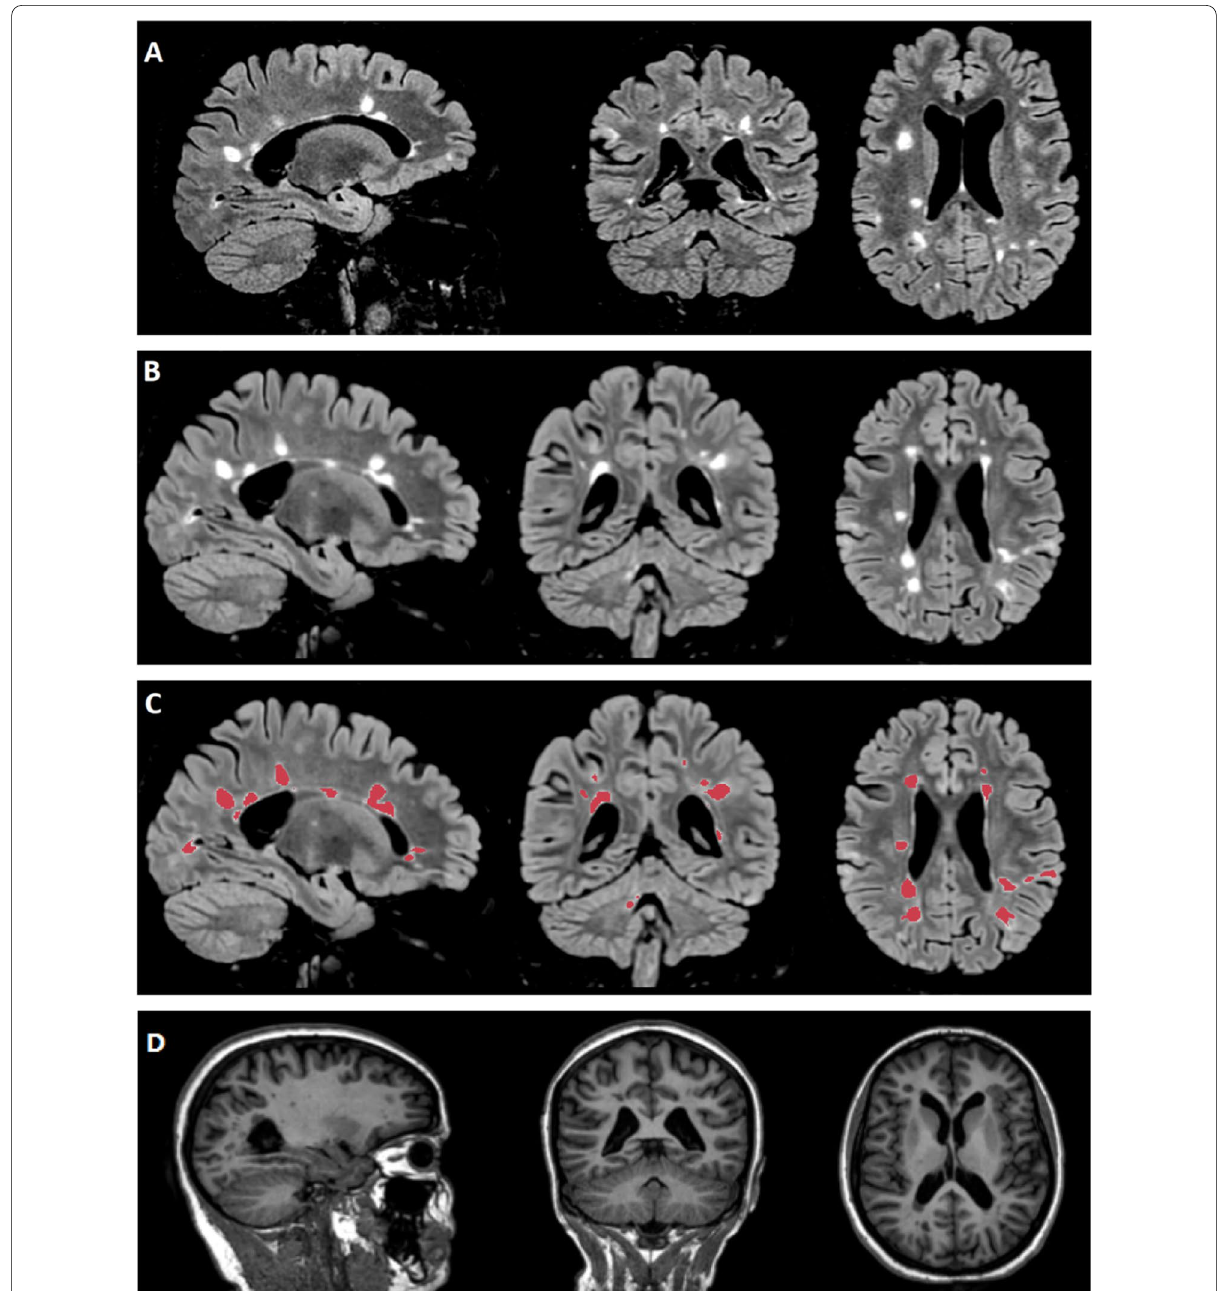
Fig. 6 A female patient aged 23 years, known to have RRMS with EDSS score of 5.5. White matter lesions segmentation: T2 FLAIR images in sagittal, coronal, and axial planes; a raw unprocessed image showing white matter hyperintense lesions located at the periventricular and deep white matter, b T2 FLAIR image after registration to MNI template and c processed T2 FLAIR image with segmented white matter lesions. Deep grey matter structures segmentation: T1W images in sagittal, coronal, and axial planes; d raw unprocessed T1W images, e T1W images after registration to MNI template, and f and g T1W images with coloured segmented grey matter structures with thalamus in orange, caudate in red, putamen in green, and hippocampus in blue. Grey matter structures volumes after correction for ICV: Left and right thalamus: 0.00326 and 0.00276 cm 3 , left and right caudate: 0.00239 and 0.00254 cm 3 , left and right putamen: 0.00213 and 0.00213 cm 3 , left and right hippocampus: 0.00253 and 0.00262 cm 3 . White matter lesions volume: 10.2 cm 3 . We found that the patient had a significant decrease in the volumes of the thalamus and putamen bilaterally with white matter lesions volume of 10.2 cm 3 and EDSS score of